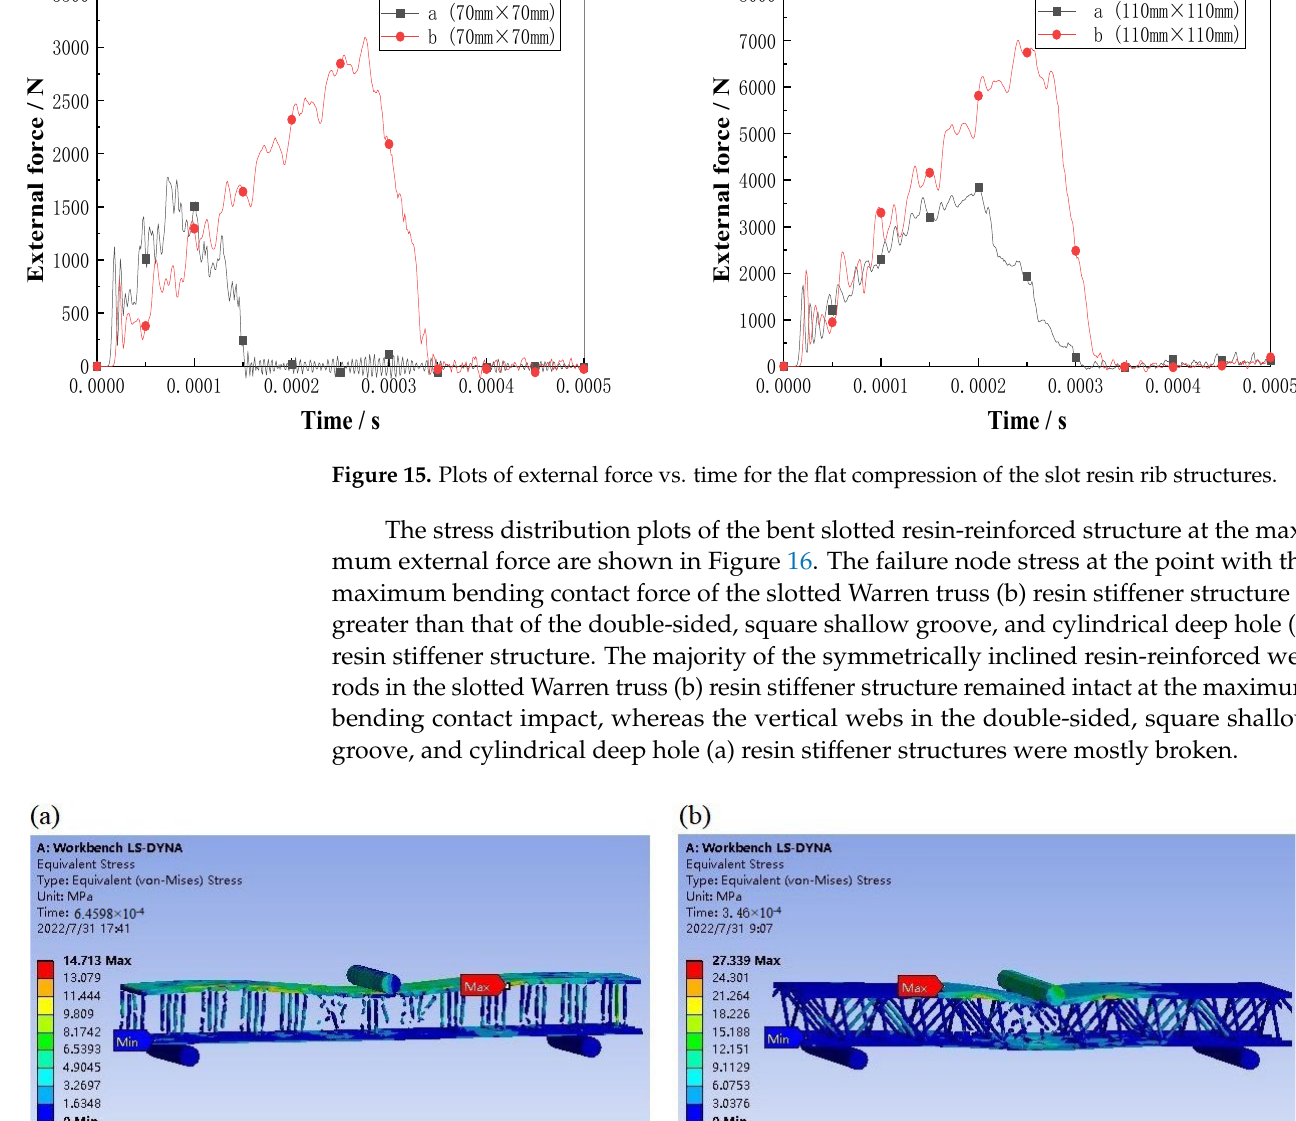
Figure 16. Bending failure stress nephogram at the maximum contact force. the double-sided, square shallow groove, and cylindrical deep holes ( a ) and optimized Warren truss with symmetrically inclined holes ( b ) resin stiffener structures.